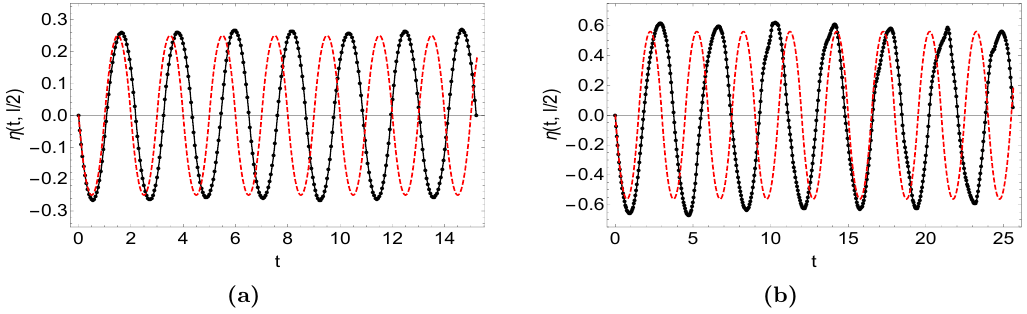
Figure 20. Numerical solution (cid:17) ( t; l ) (black line) in the perturbed model. The exact breather 2 solution (cid:30) ( t; l ) is given by dashed red line. The (cid:12)gures correspond to (a) l = 2 : 0, (b) l = 3 : 2